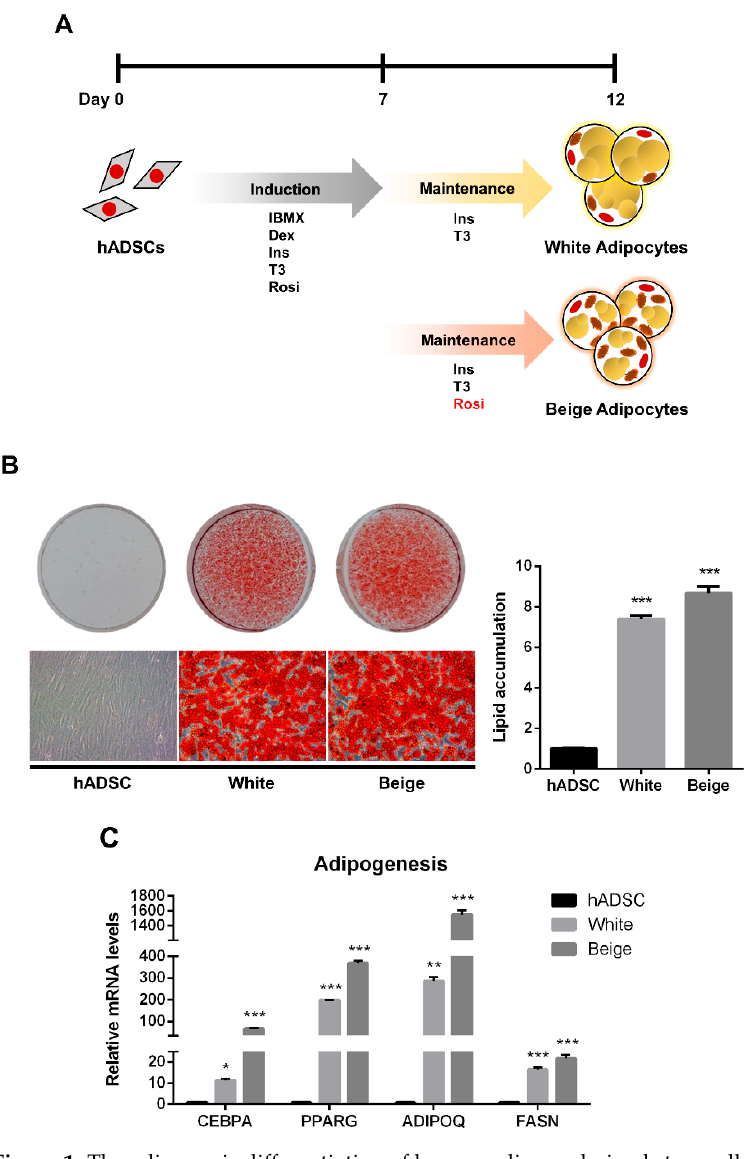
Figure 1. The adipogenic differentiation of human adipose-derived stem cells. ( A ) Schematic images of human adipose-derived stem cell differentiation into white and beige adipocytes. ( B ) The cells were stained with Oil Red O. The lipid accumulation levels were measured by absorbance at 490 nm by extracting Oil Red O dye with isopropanol. ( C ) The expression levels of adipogenic genes were assayed by qPCR. Results are shown as mean ± SEM. * p < 0.05; ** p < 0.01; *** p < 0.005 compared to the hADSC group.